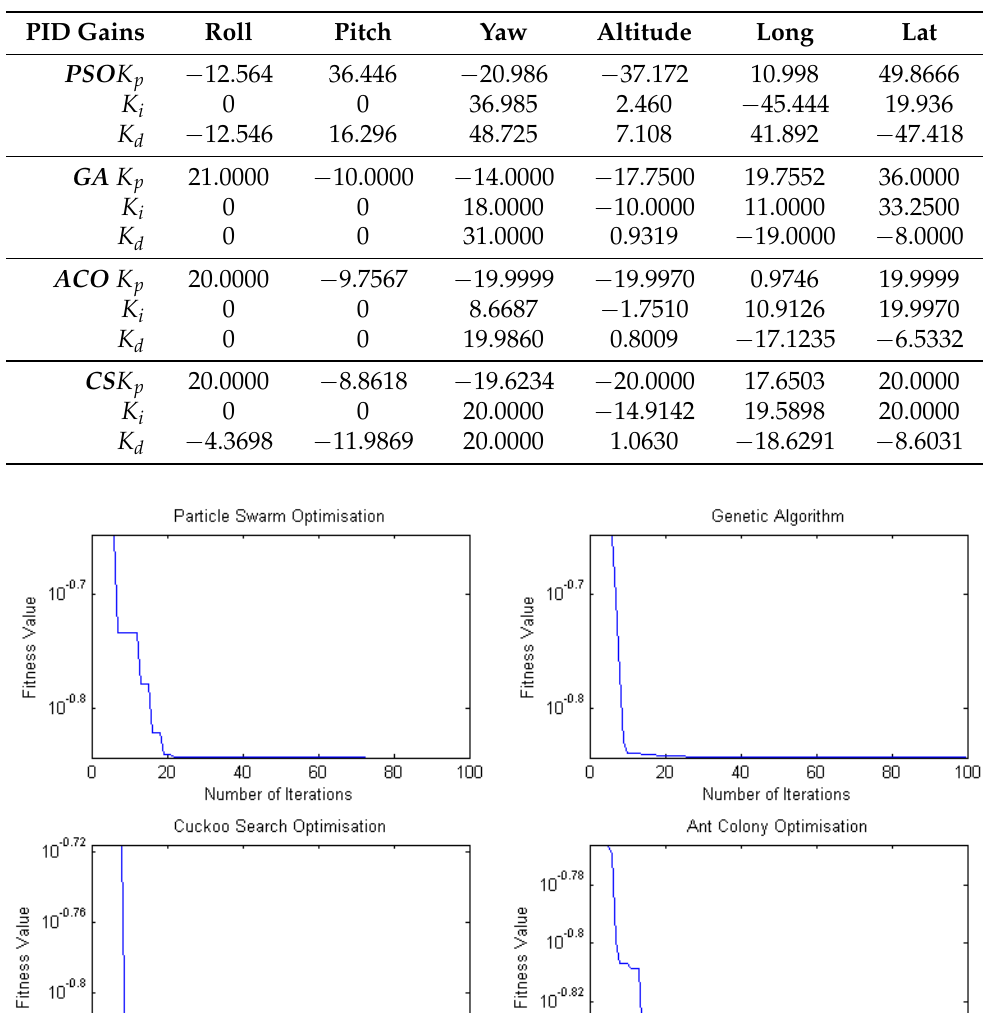
Table 7. The four PID controllers’ gains found using optimisation for hover conditions.